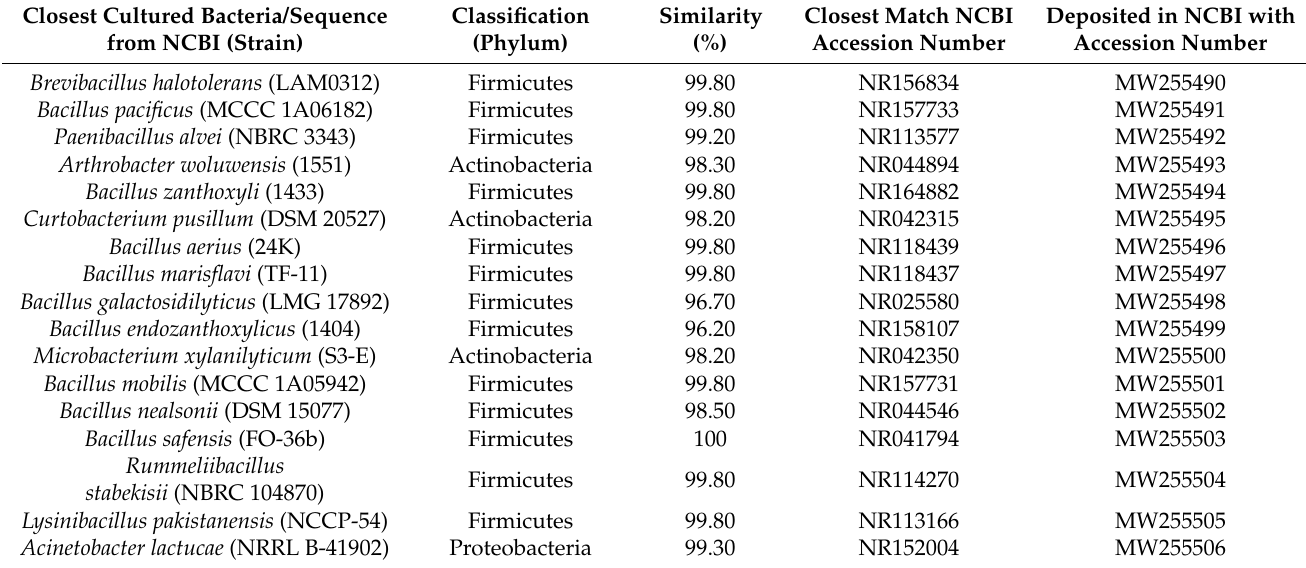
Table 1. Bacteria isolated from the Solenopsis invicta nest